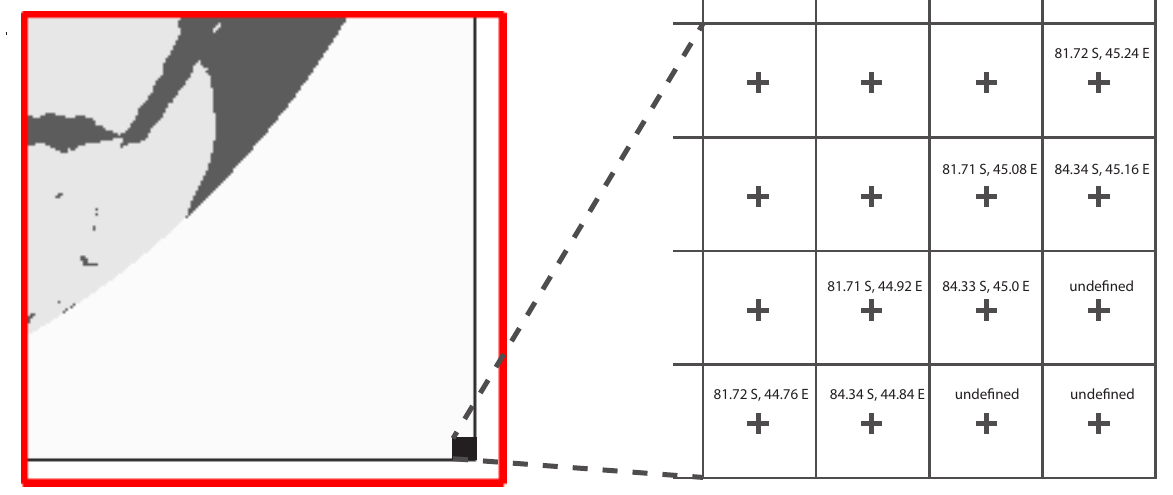
Figure 4. Zoomed area of lower right corner of Northern EASE-Grid projection in Figure 1, indicating 25-kilometer corner pixels with undefined (latitude, longitude) coordinates. All corners are